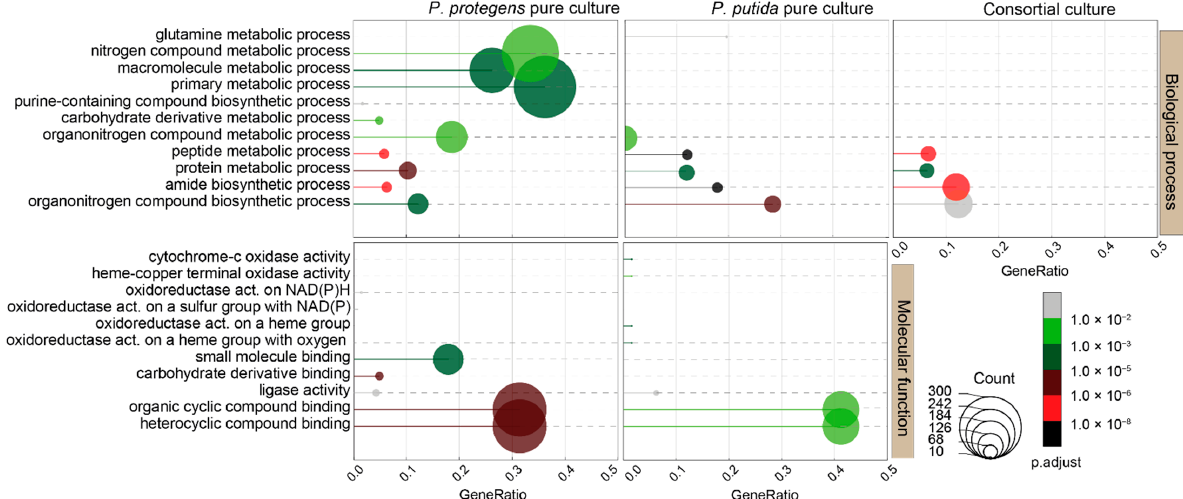
Figure 3. Over-representation of GO terms in pure and co-cultures of P. protegens and P. putida . We obtained enriched GO terms using Blast2GO, InterProScan and the nr database of the Pseudomonas genus with a BLAST expectation value of 1 × 10 − 3 , and then merged these results to calculate the GeneRatios (number of genes that over-expressed compared to the number of genes with the same term in the whole genome), adjusted p-values and the number of genes that were enriched in the